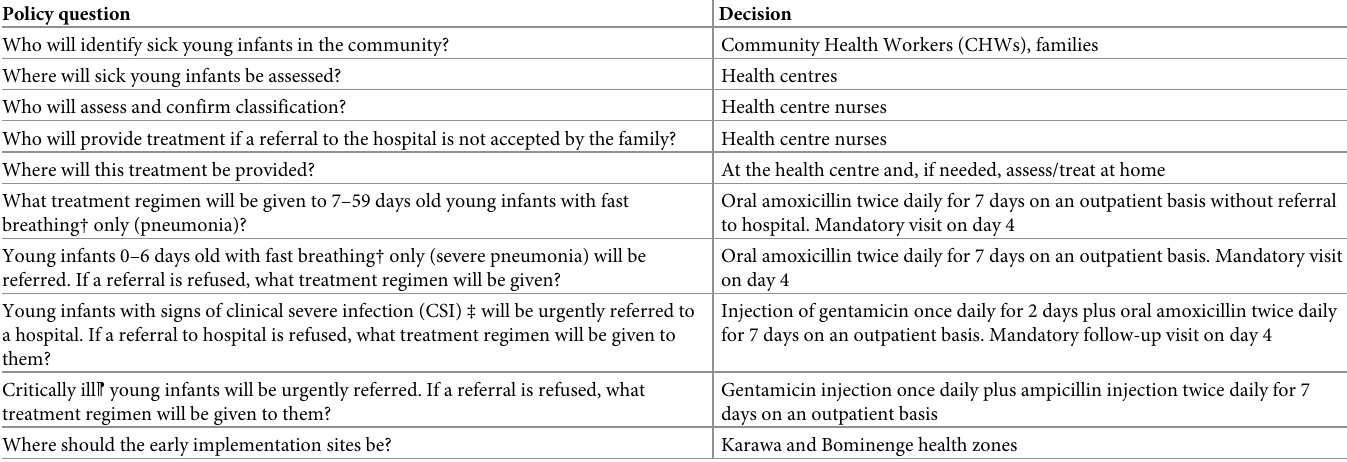
Table 1. Decisions made during the policy dialogue meeting for the management of sick young infants with possible serious bacterial infection (PSBI) � when a referral is not feasible. Policy question